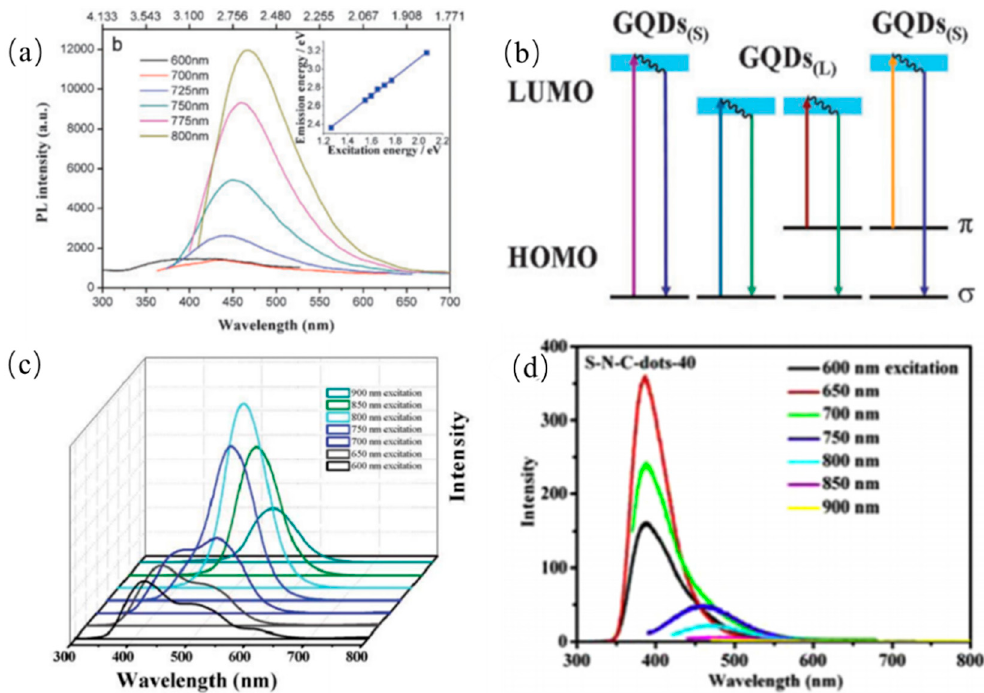
Figure 15. ( a ) The up-converted emission of PEG passivated GQDs, and ( b ) The proposed normal and UCPL emission mechanism of GQDs [135]. Copyright 2011, Royal Society of Chemistry. ( c ) The red-shifts of the up-conversion PL emission of GQDs [136]. Copyright 2012, Royal Society of Chemistry. ( d ) The up-conversion PL properties of the N-S-CQDs [109]. Copyright 2013, Elsevier.